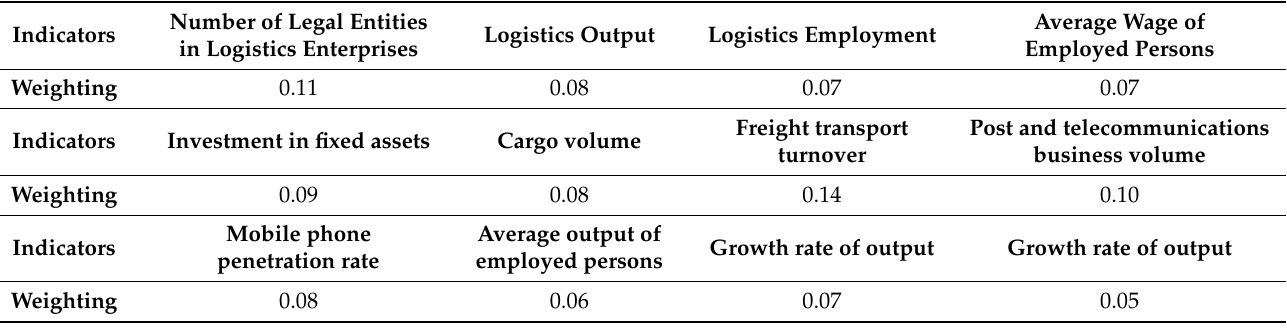
Table 2. Indicator weights for regional